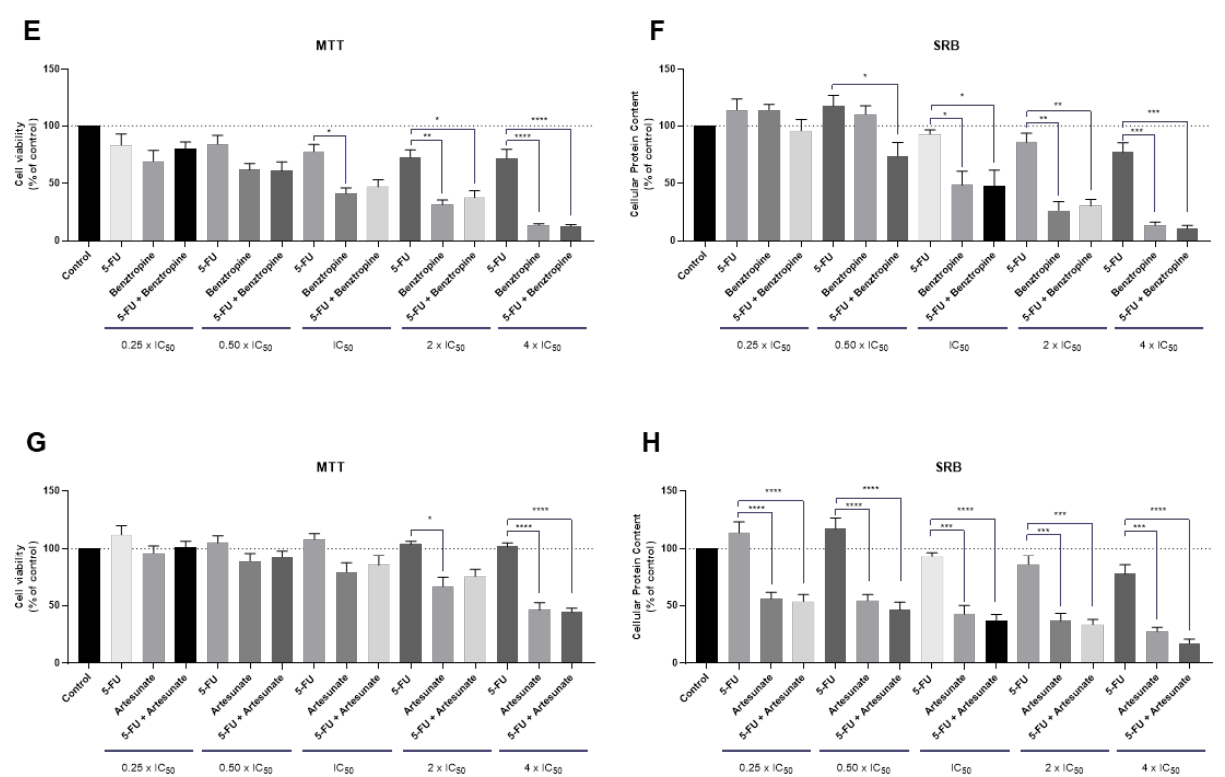
Figure 6. Growth inhibition of HT-29 after 48 h of combination therapy, by MTT (left) and SRB assays (right). Cells were exposed to concentrations of each drug of 0.25, 0.5, 1, 2 and 4 times their IC 50 and cell viability were evaluated by MTT and SRB assays. The drugs in combination were co-administered at the same time. ( A ) The effect of 5-FU plus fluphenazine on cell viability and ( B ) cell protein synthesis. ( C ) The effect of 5-FU plus fluoxetine on cell viability and ( D ) cell protein synthesis. ( E ) The effect of 5-FU plus benztropine on cell viability and ( F ) cell protein synthesis. ( G ) The effect of 5-FU plus artesunate on cell viability and ( H ) cell protein synthesis. Values are expressed in percentage of control and represent means ± SEM. Each experiment was done three times independently ( n = 3); * statistically significant vs. control at p < 0.05. ** statistically significant vs. control at p < 0.01. *** statistically significant vs. control at p < 0.001. **** statistically significant vs. control at p < 0.0001.